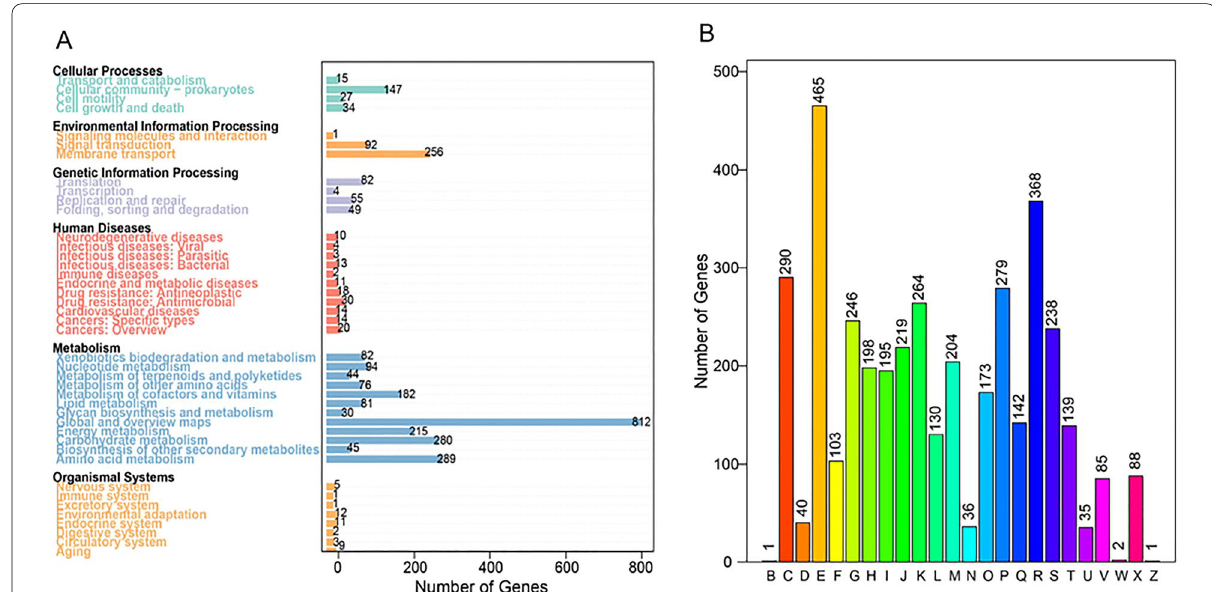
Fig. 1 KEGG pathway mapping ( A ) and COG functional assignment ( B ) of genes in the genome of strain MA5. The numerical value above the column represents the number of genes in the corresponding pathway or classification. The genes were mainly concentrated in the category of metabolism in KEGG pathway mapping and on amino acid transport and metabolism in COG function